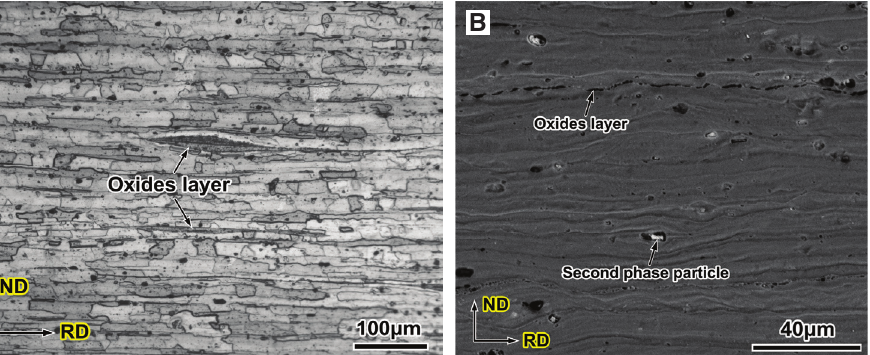
Figure 2 Micrographs of TD section of the processed 1280 layer composite sheets: (A) optical image for 4-mm thick 1280 layer sheet after annealing at 400 ° C for 1 h; (B) SEM micrograph of 1-mm thick 1280 layer sheet after 75% cold rolling, showing wavy lamellar microstructure with some oxide layers and constituent particles, which were identified as Al